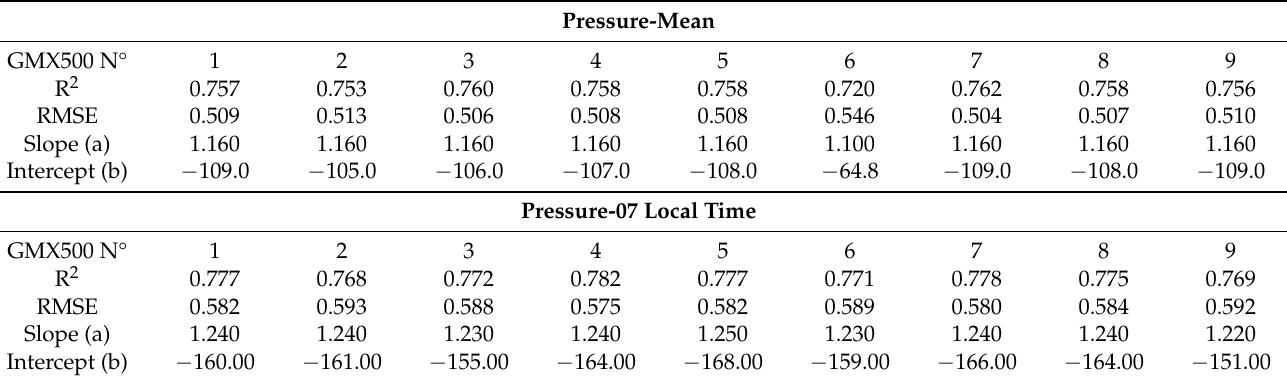
Table A2. Statistical results of the evaluation of temperature of the GMX500 sensors with a conven- tional weather